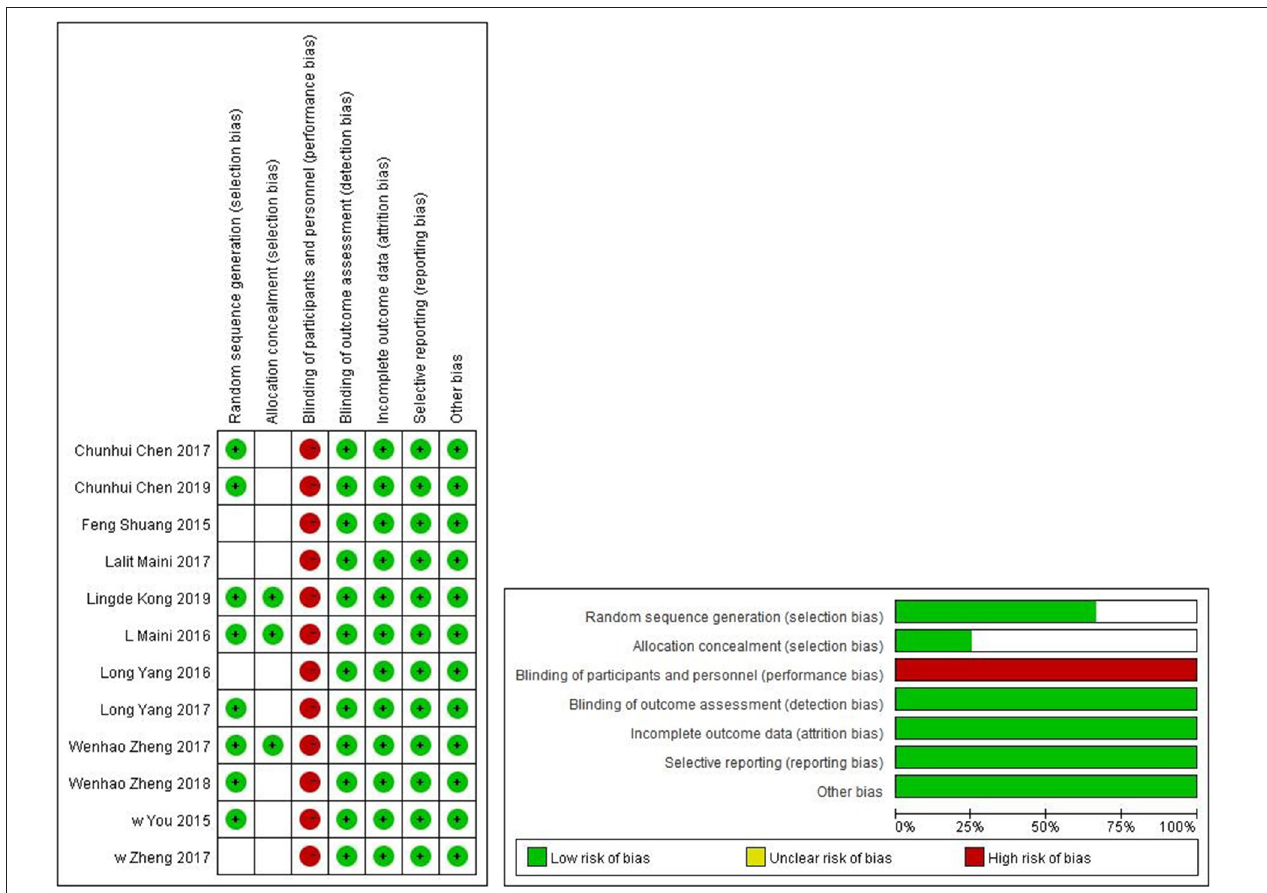
FIGURE 2 | Risk of bias assessment table and risk of bias assessment chart of